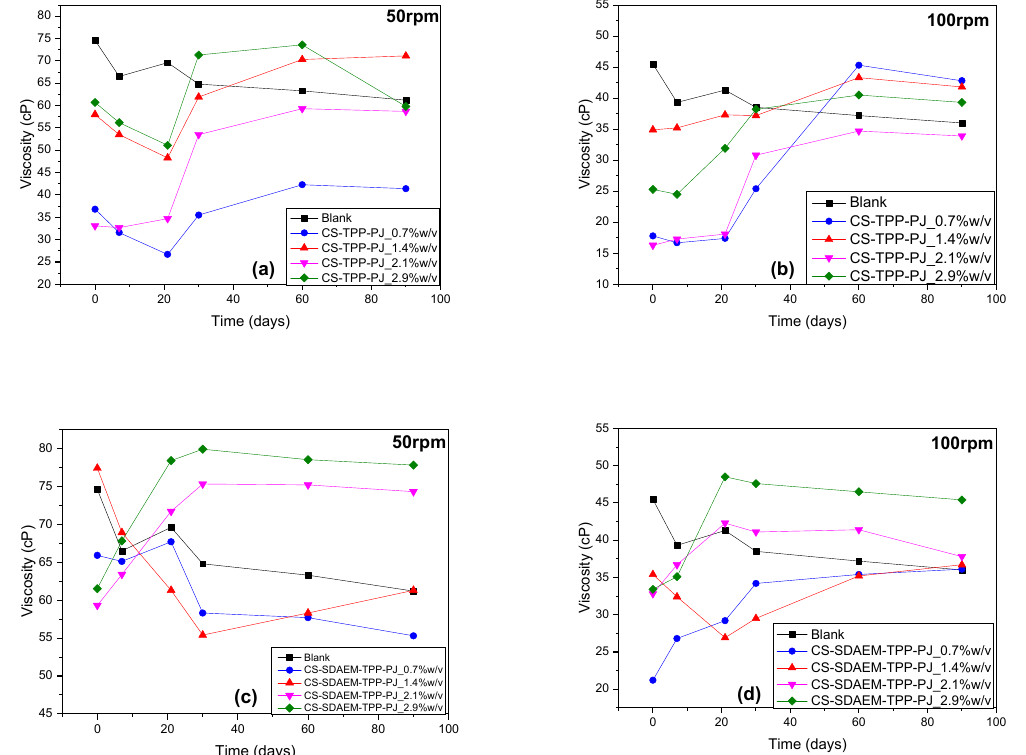
Figure 11. Viscosity values of the prepared emulsions during 90 days ( a ) CS-TPP-PJ_0.7, 1.4, 2.1 and 2.9% w / v 50 rpm, ( b ) CS-TPP-PJ_0.7, 1.4, 2.1 and 2.9% w / v 100 rpm ( c ) CS-SDAEM-TPP-PJ_0.7, 1.4,